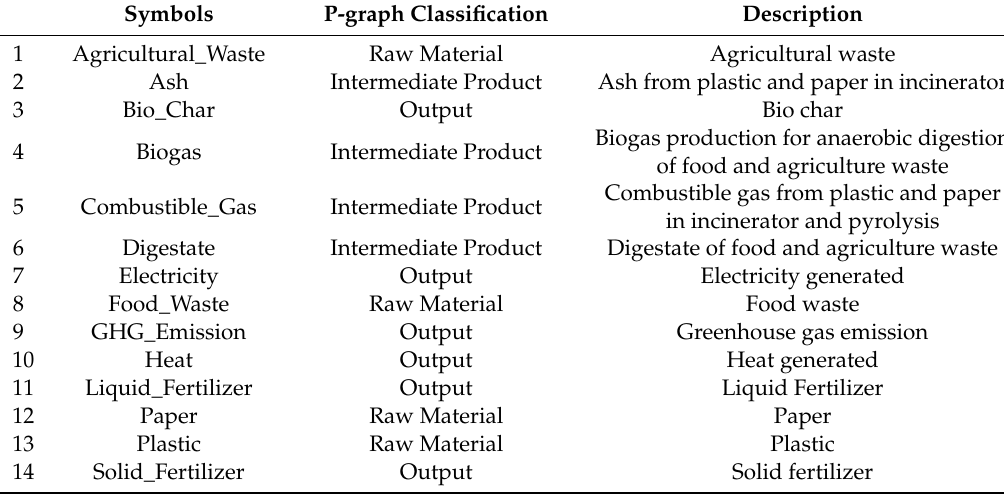
Figure 4. Graphical representation of materials in P-graph. Table 2. Materials and products for the P-graph.